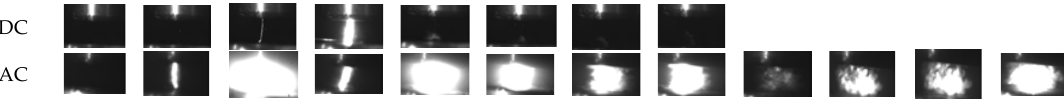
Figure 8. The breakdown progress of the cylinder-plan electrodes in the oil.